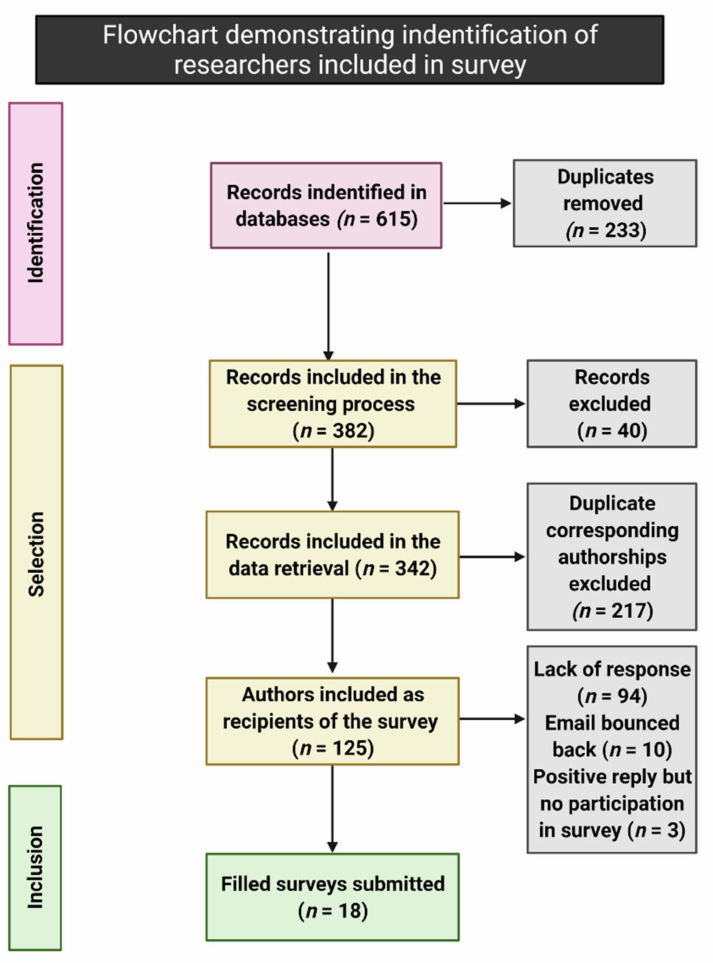
Figure 1. The diagram visualizes the selection process of research groups and researchers invited to participate in the survey. “ n ” signifies the number of